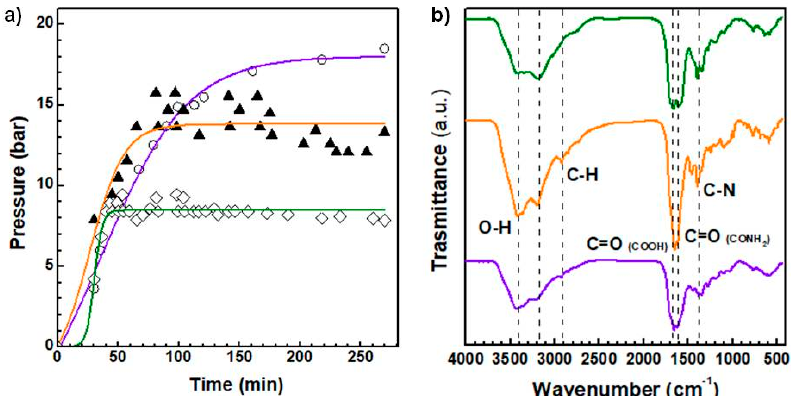
Table 1. Reaction yield of the carbon nanodots (CDs) obtained at different operating pressure.